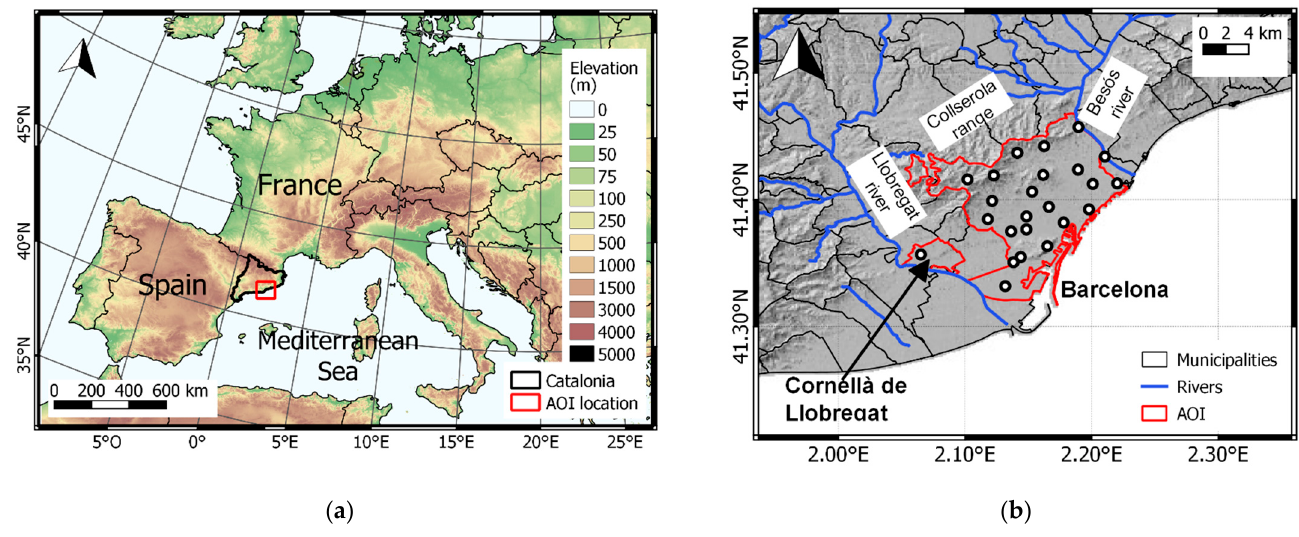
Figure 1. ( a ) Geographical location of Catalonia and the Region of Interest (ROI). ( b ) ROI (in red) and the region selected to analyse radar data. White dots represent the rain gauge network managed by BCASA. The main rivers surrounding Barcelona (Llobregat and Besós) are labelled, as well as the main mountain range (Collserola).